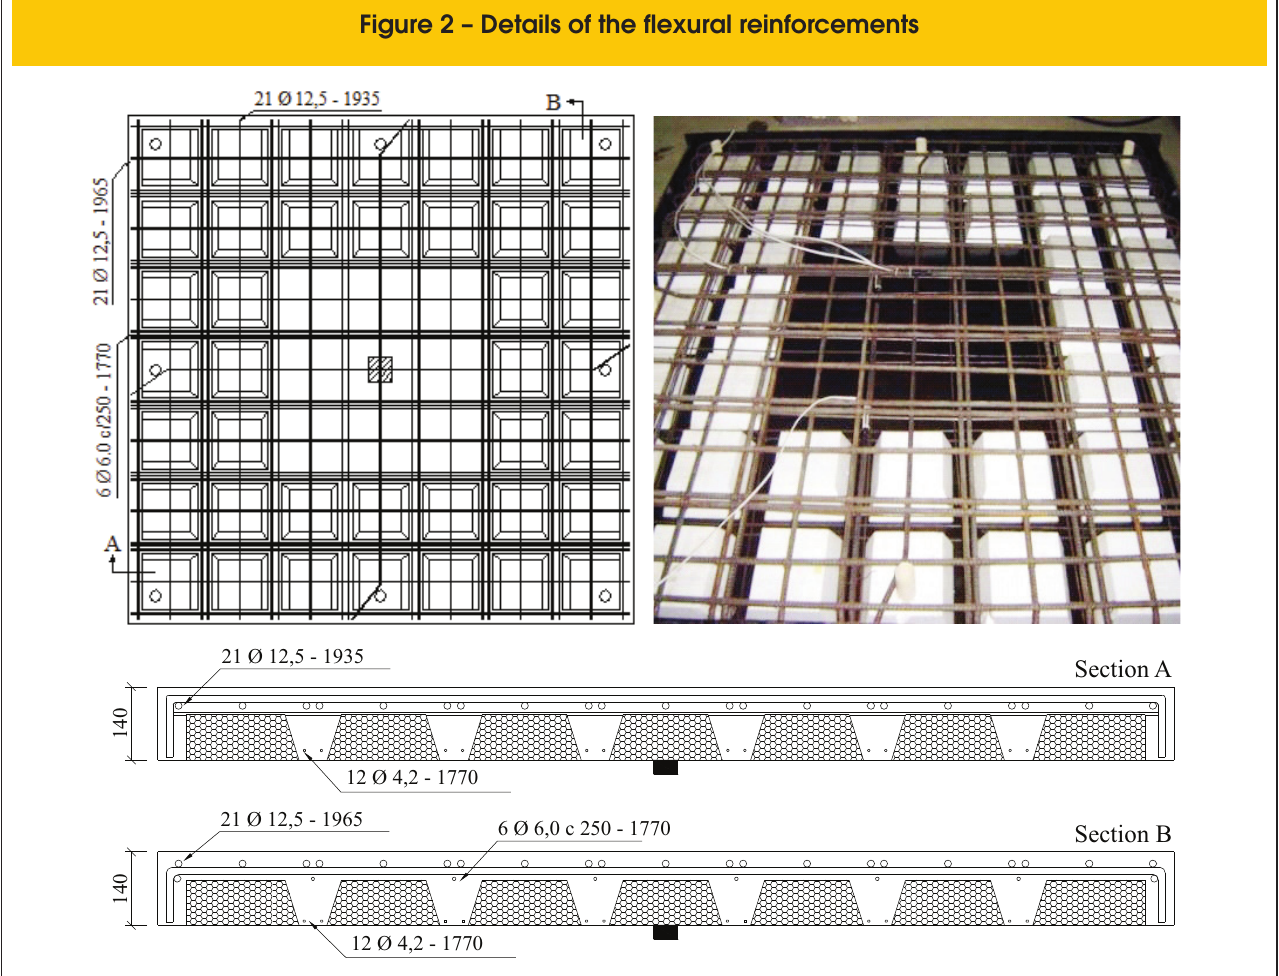
Figure 2 – Details of the flexural